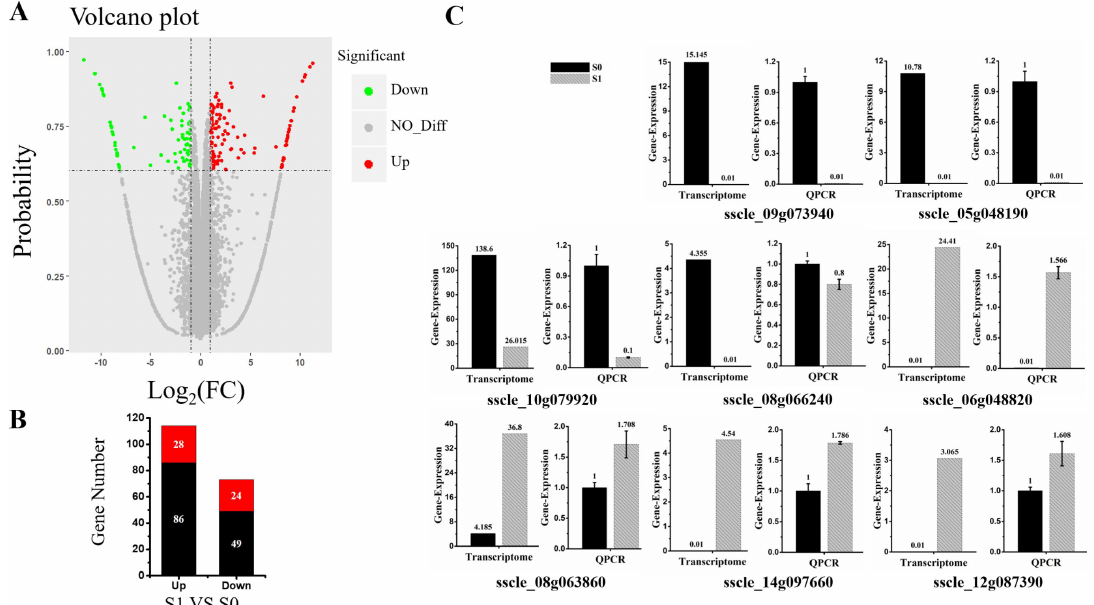
Figure 2. Differentially expressed genes between virus-infected and virus-free samples. ( A ) Volcano plot displaying probability on the Y-axis, index of gene differences from NOIseq, and Log2 (fold-change (FC)-value) on the X-axis. The red dots represent up-regulated differentially expressed transcripts between virus-infected and virus-free samples, green dots represent down-regulated transcripts, and gray dots indicate genes not showing statistical significance. ( B ) Stacked column showing statistics of differential genes, and red represents significantly expression genes. ( C ) The expression of eight DEGs (four up-regulated and four down-regulated DEGs) were examined via RT-qPCR. Three technical replicates were performed for each RT-qPCR. The ubiquitin gene was used as a reference